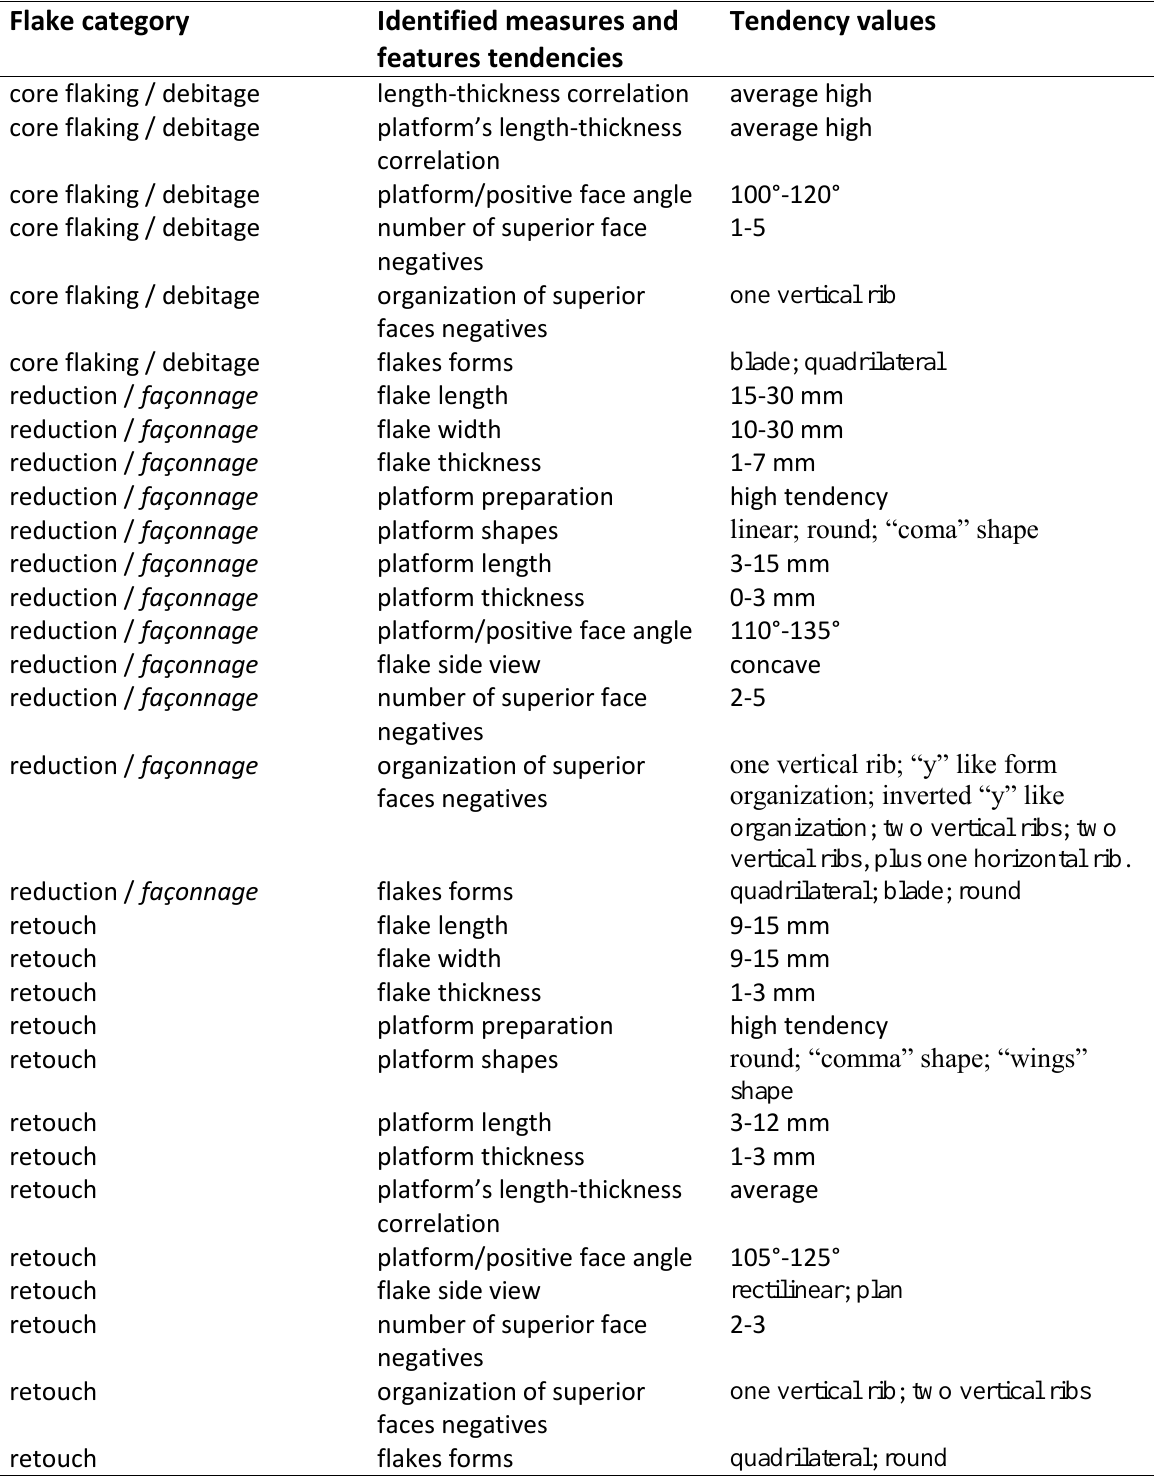
Table 4. Main identified tendencies at Gruta das Araras Rockshelter lithic